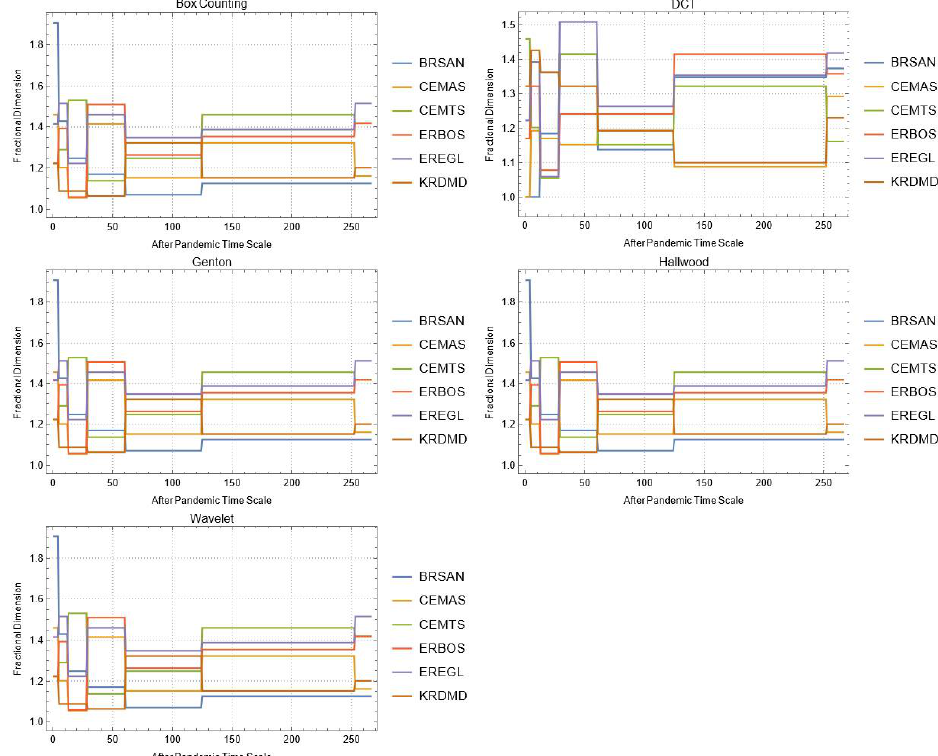
Figure A17. Daily changes of fractal dimensions after the pandemic (real estate).